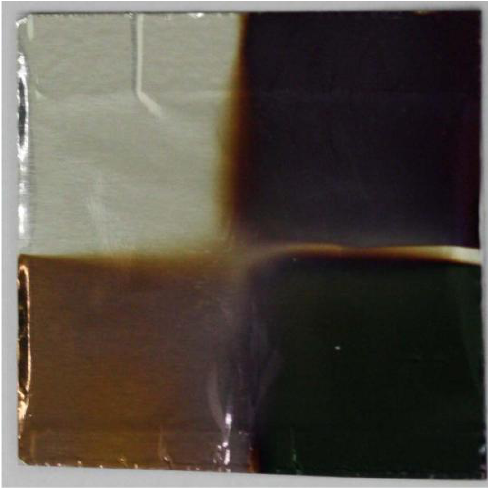
Figure 8. True photograph of 50 nm gold nanocomposite with (13%), (20%) and (30%) filling factor on aluminum foil resulting in different color. The white are (top left) is the bare aluminum